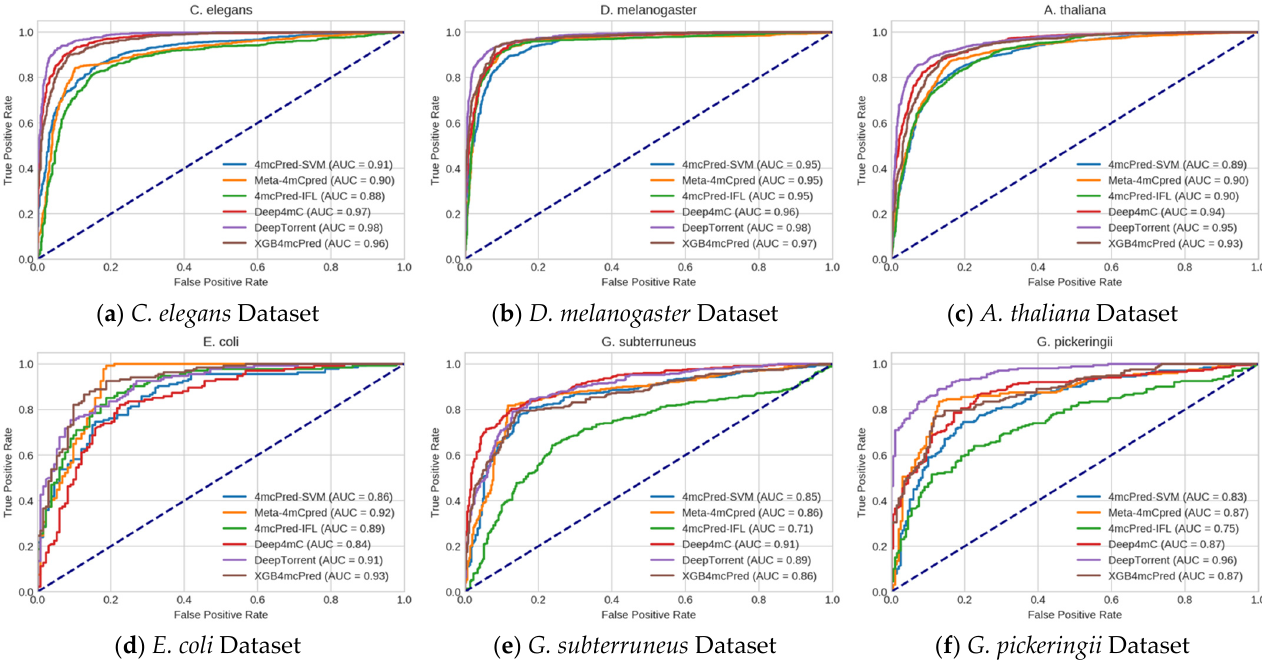
Figure 9. Performance comparison of XGB4mcPred and other state-of-the-art predictors of the AUC value on independent datasets from multiple